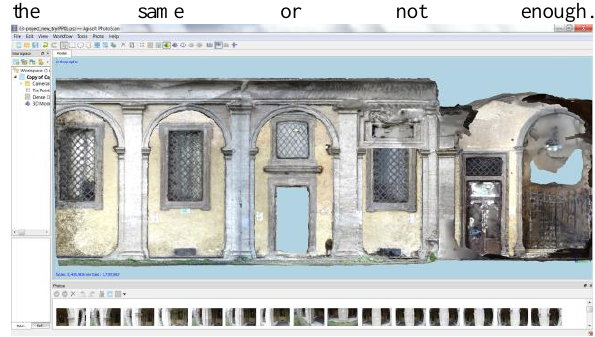
Figure 5.Photoscan 3D textured surface model